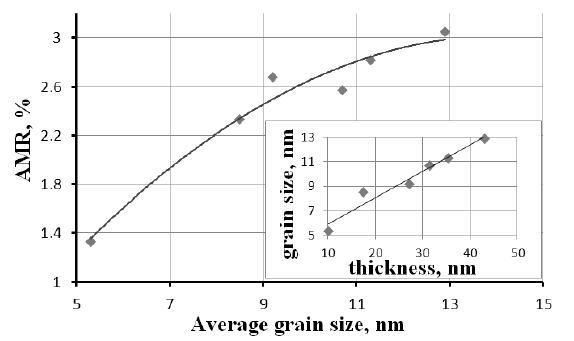
Fig. 7. The dependence of the AMR on the average grain size and film